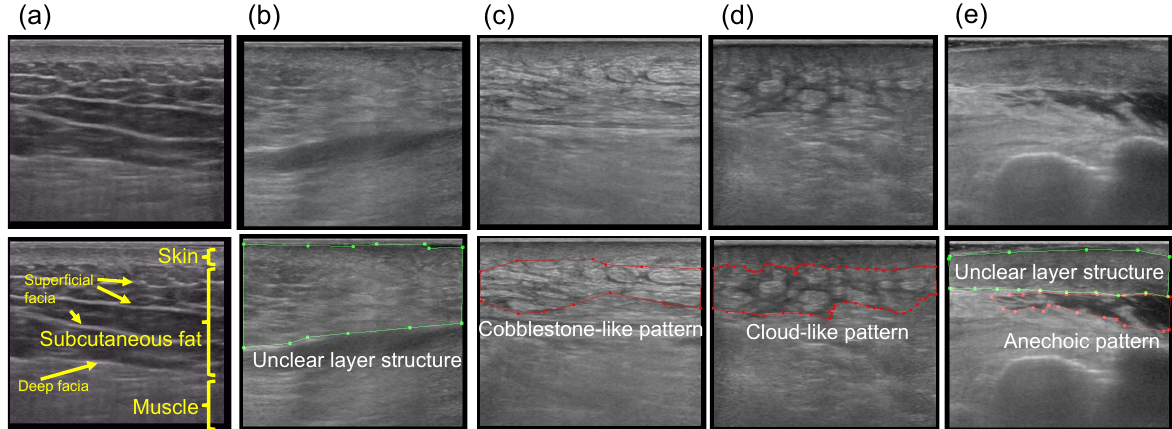
Figure 1. Examples of annotation in training data. ( a ) Normal and clear layer structure (excluded in the training data). ( b ) Unclear layer structure. ( c ) Cobblestone-like pattern. ( d ) Cloud-like pattern. ( e ) Anechoic pattern. The top images show the original image, and the bottom images show the annotated image. The polygons in the bottom images show the regions manually extracted by the expert.